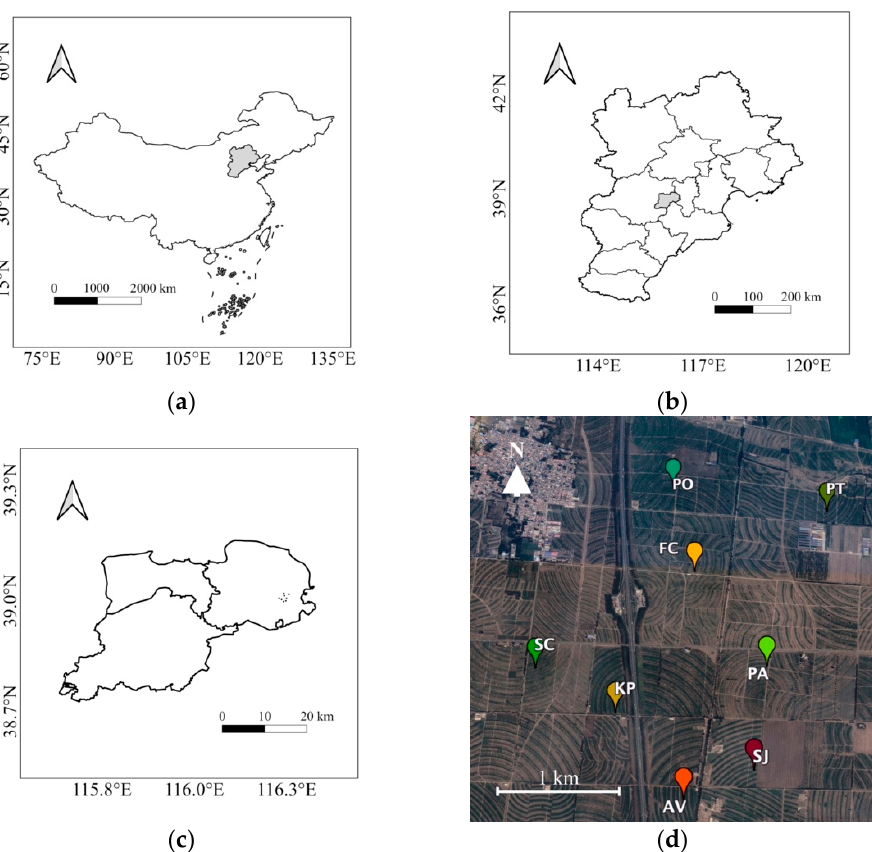
Figure 1. Geographical location of sampling site: ( a ) China; ( b ) Beijing–Tianjin–Hebei urban agglom ‐ eration; ( c ) Xiong’an New Area; ( d ) studied stands (http://earth.google.com/). (AV, A. vulgaris ; SJ, S. japonica ; KP, K. paniculata ; FC, F. chinensis ; PO, P. orientalis ; PT, P. tabuliformis ; PA, P. asperata ; SC, S. chinensis .)